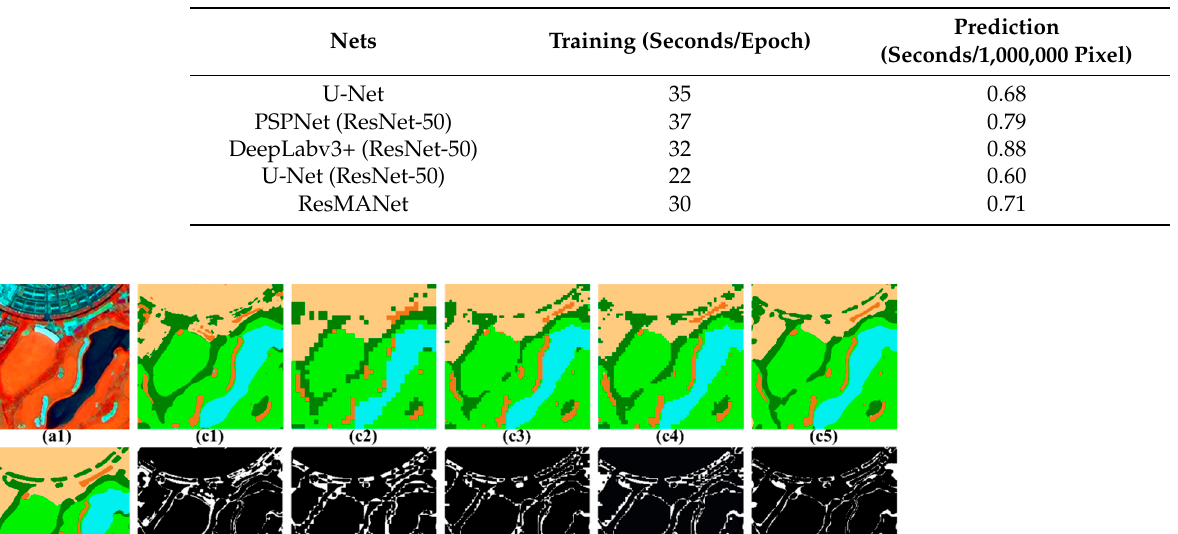
Table 4. Comparison of training and prediction efficiency on multi-spectral data.